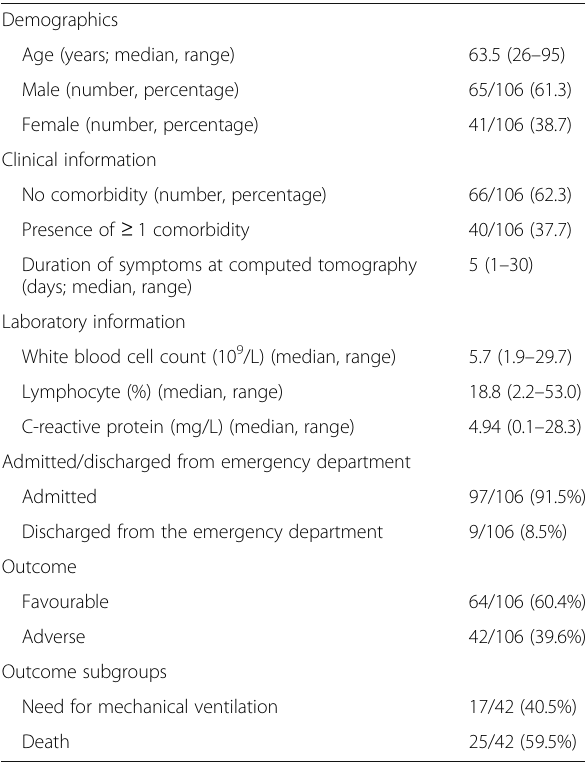
Table 1 Demographic, clinical, and laboratory data of the